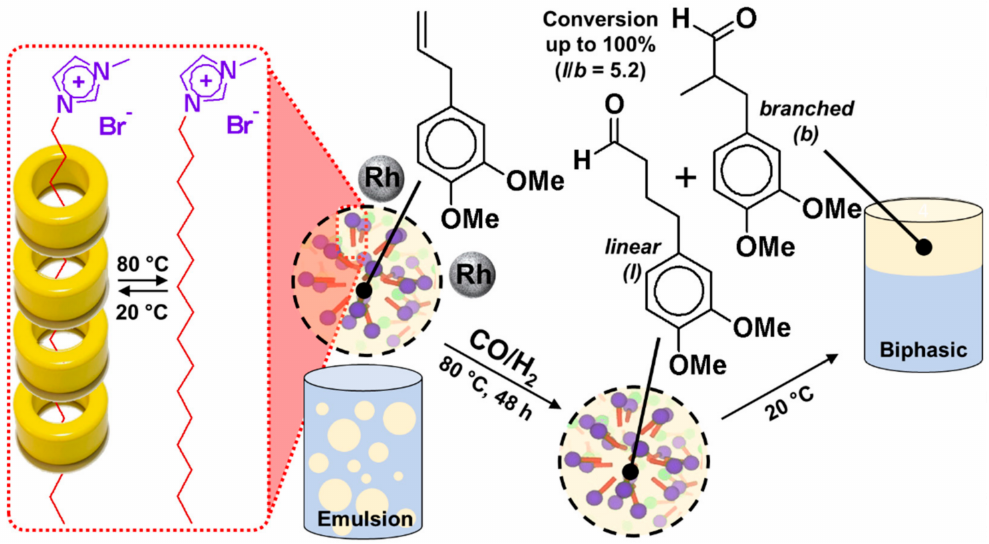
Figure 28. The combination of CD/cationic surfactant for interfacial catalysis in a thermoregulated hydroformylation reaction in an